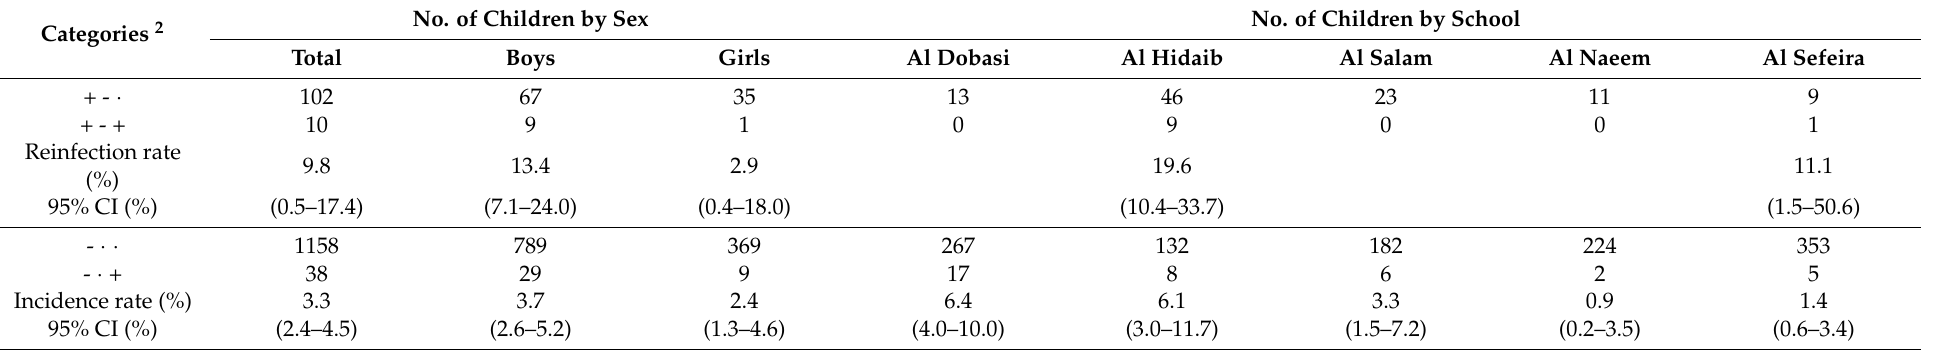
Table 5. Reinfection rate and incidence at 6 months after MDA 1